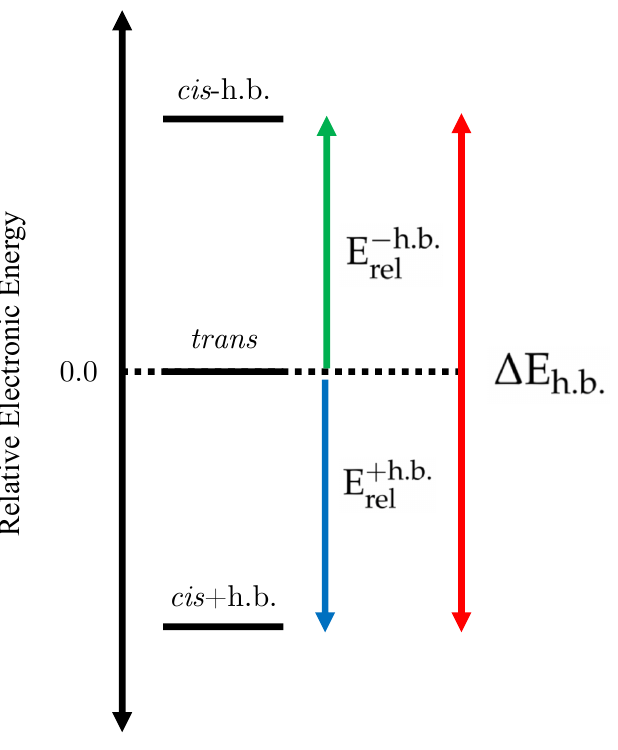
Figure 3. A schematic of the relative energies of the three different structural motifs: cis isomer without hydrogen bond, cis isomer with hydrogen bond, trans isomer.